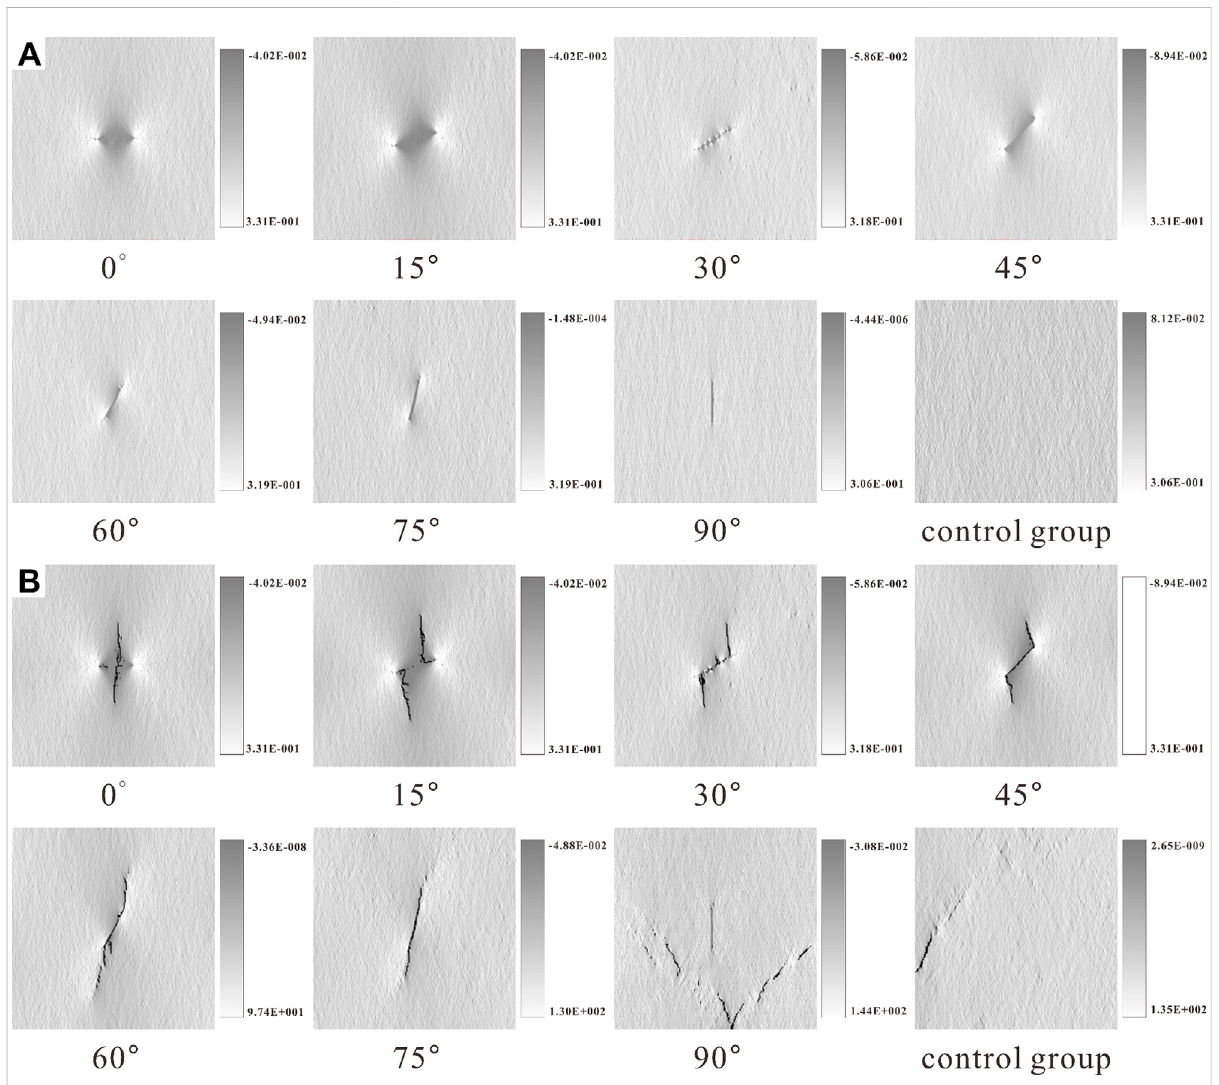
FIGURE 11 Stress distribution of microstructure of shale. (A) Stress distribution in the initial stage. (B) Stress distribution in the extension